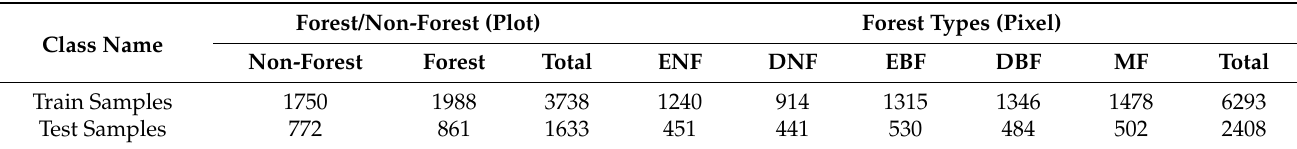
Table 3. The number of samples in the two classification levels. The sample unit are with size of 300-m by 300-m for the forest/non-forest classification and 30-m by 30-m for the forest type classification.